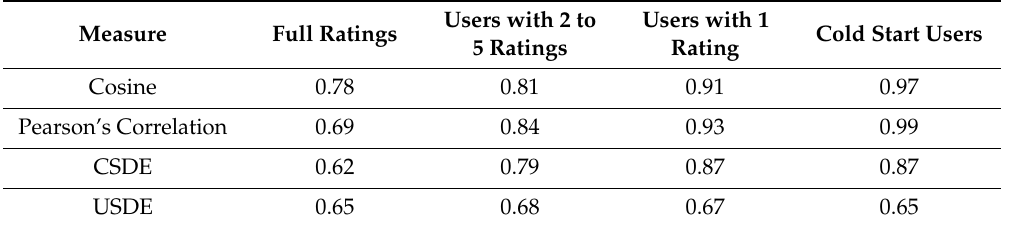
Table 12. Summary of mean absolute error (MAE) for various